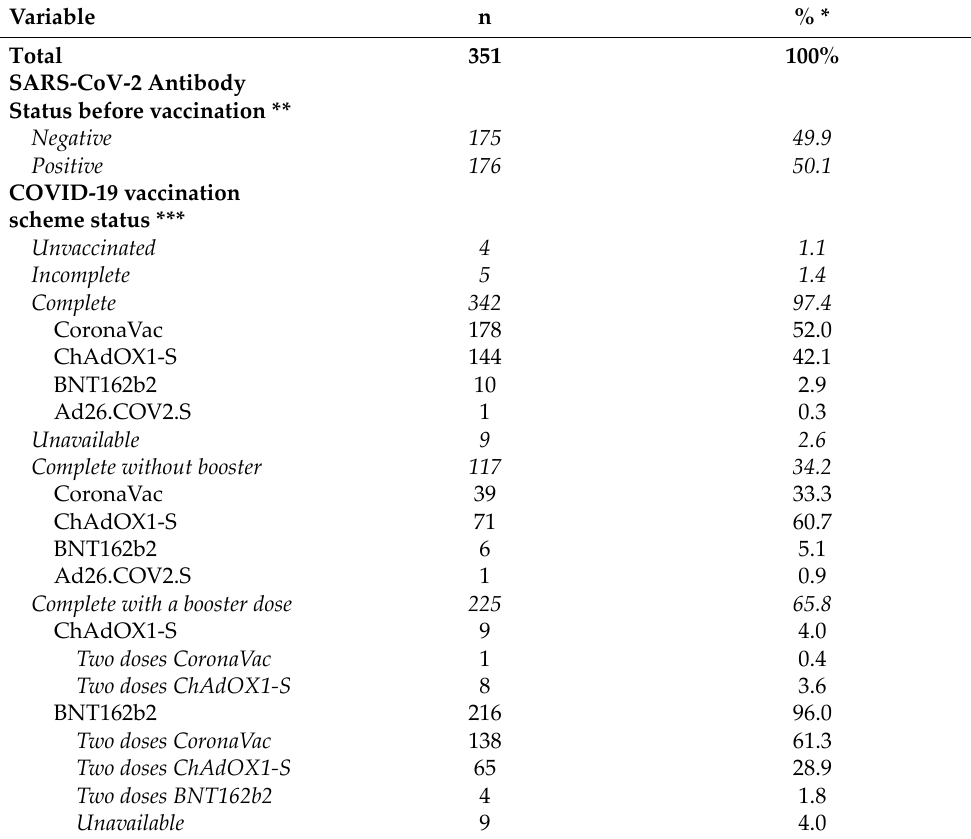
Table 3. Types of job activities performed by healthcare workers in IFF/Fiocruz. Variable n % * Occupation Healthcare professionals 198 Support workers 151 Level of workplace exposure to SARS‑CoV‑2 Low exposure Medium exposure High exposure